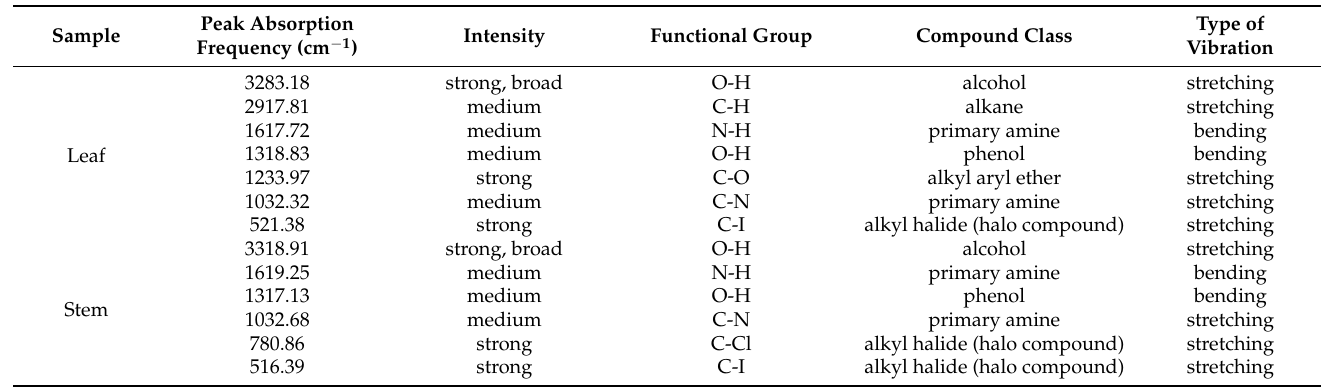
Table 3. FTIR spectral classification of powdered leaves and stems of Combretum molle .